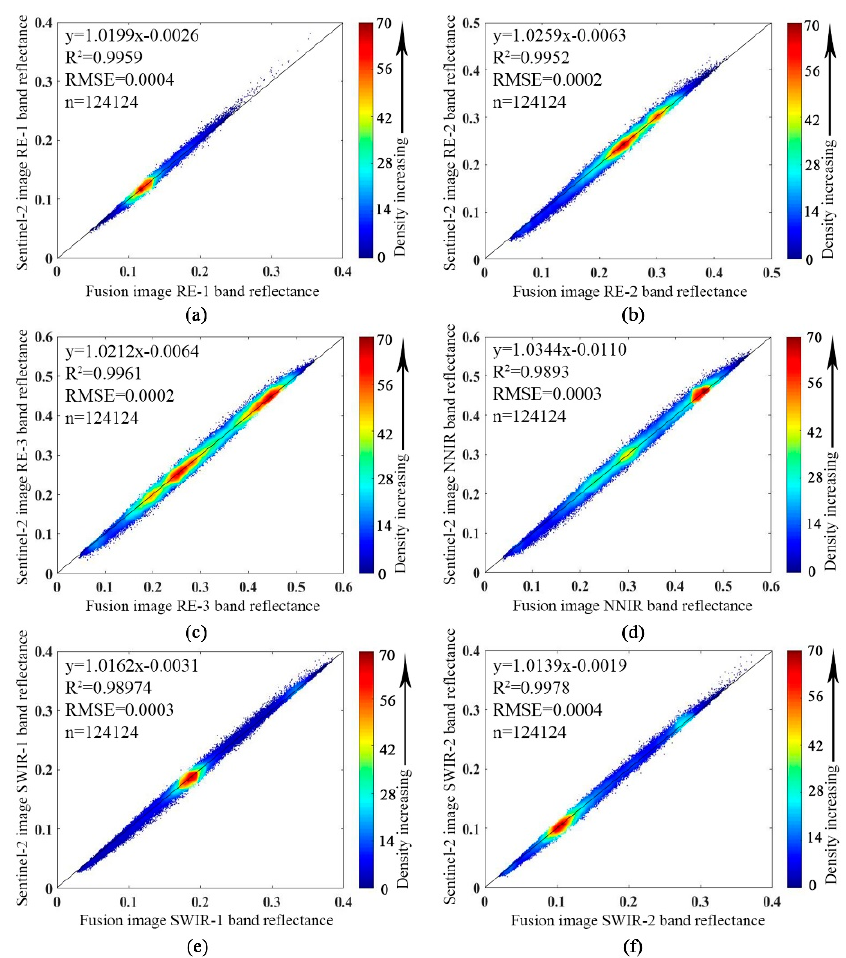
Figure 8. Comparison of RE-1 ( a ), RE-2 ( b ), RE-3 ( c ), NNIR ( d ), SWIR-1 ( e ), and SWIR-2 ( f ) bands at 12 m resolution from fused and Sentinel-2 images.